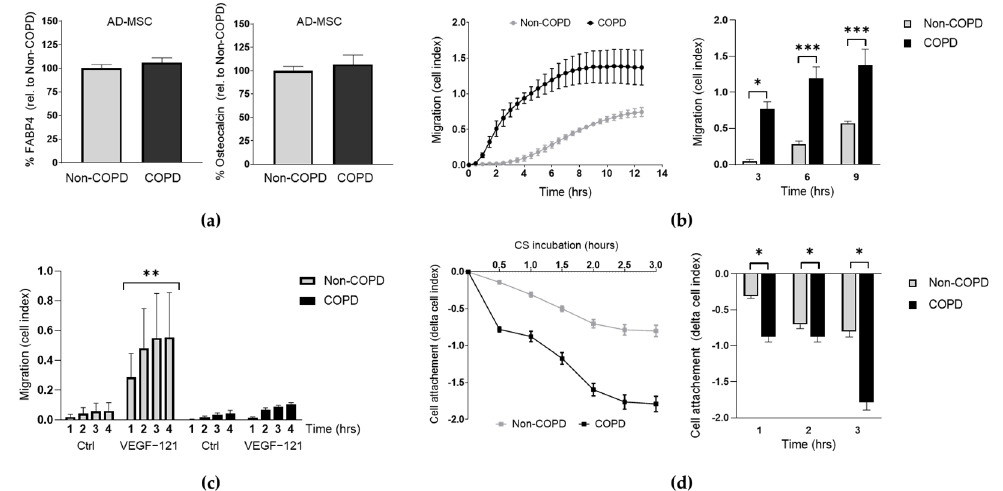
Figure 1. COPD derived AD-MSC have impaired migration in response to VEGF and cigarette smoke stimulus. ( a ) Analysis of the cell differentiation capability of AD-MSC from non-COPD and COPD patients into adipocytes (FABP4) and osteoblasts (osteocalcin) upon 21 days of stimulation. Data presented as % protein levels relative to non-COPD. ( b ) Migration assay of AD-MSC from non-COPD ( n = 3) and COPD ( n = 4) patients at baseline conditions. Two-way ANOVA, Bonferroni post-test. ( c ) Migration assay of AD-MSC from non-COPD ( n = 4-6) and COPD ( n = 3) patients in response to VEGF-121 at the time points indicated. Two-way ANOVA, Dunnet’s post-test. ( d ) Cell attachment of AD-MSC from donor and COPD patients in response to CSM at real time during 3 h. Pool of 3 patients per condition. Student’s paired t -test. p values: * p < 0.05, ** p < 0.005, *** p < 0.0005. Abbreviations: AD-MSC (adipose tissue MSC), control (Ctrl), CS (cigarette